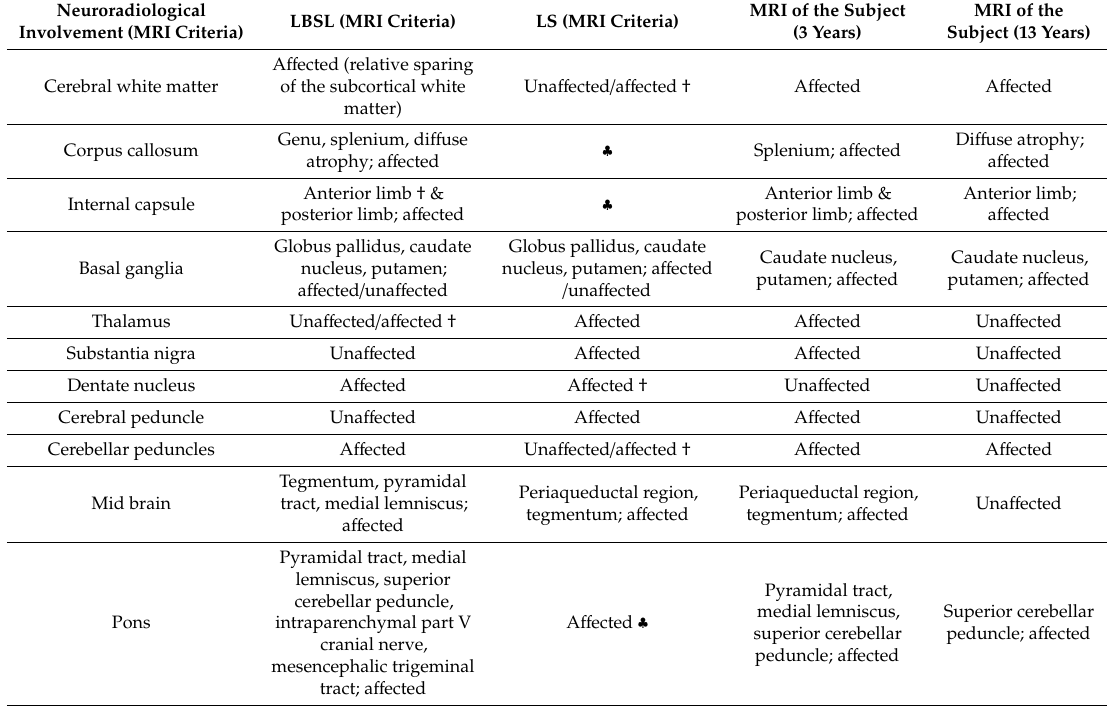
Table 1. Similarities and dissimilarities of MRI signals of the subject with LBSL and LS. Neuroradiological Involvement (MRI